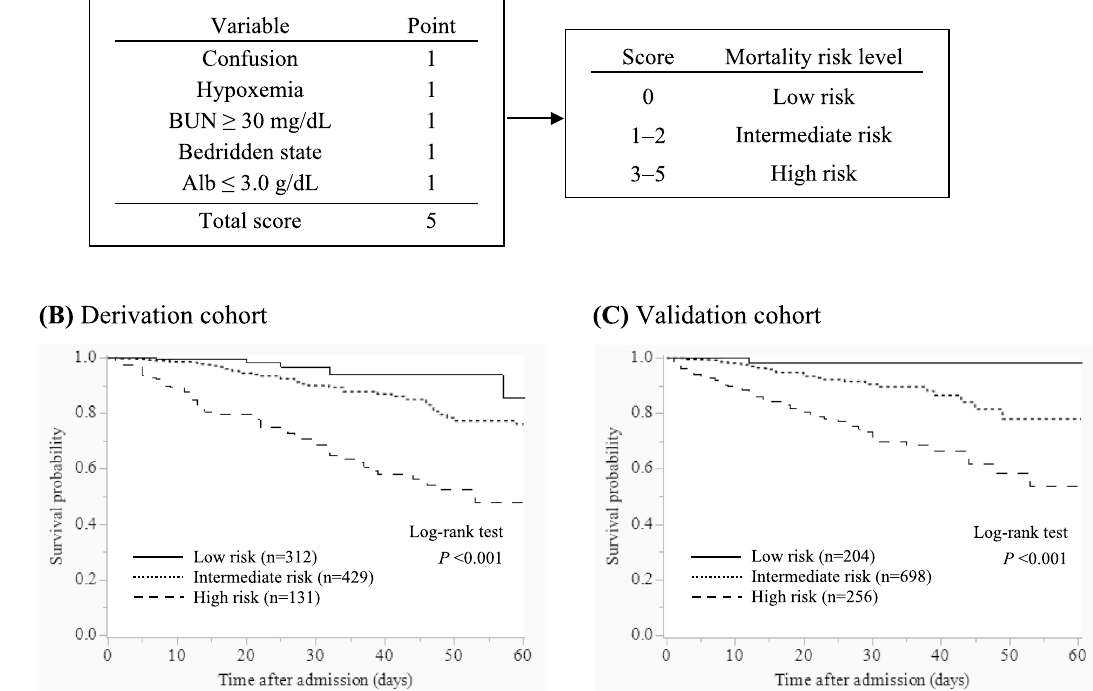
Figure 2. A new scoring system for prognostic prediction of community-acquired pneumonia in older patients and mortality risk stratification. ( A ) CHUBA (confusion, hypoxemia, urea, bedridden, albumin) was developed as a new scoring system, each variable of which was evenly allocated one point. All patients were stratified into three risk groups according to the CHUBA score. BUN, blood urea nitrogen; Alb, albumin. ( B , C ) Kaplan– Meier analysis of survival probability, stratified into low-risk, intermediate-risk, and high-risk groups according to the CHUBA score in the derivation and validation cohorts. The log-rank test indicates a significant difference between the survival curves in both cohorts (both P <